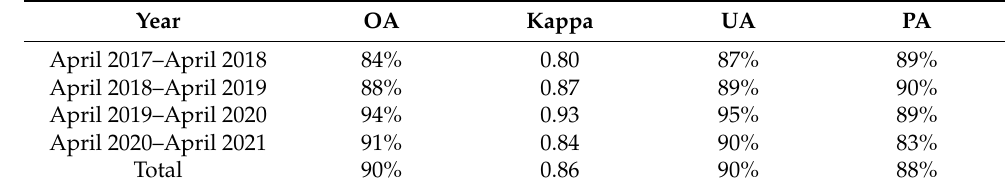
Table 1. Overall accuracy of classification in each year